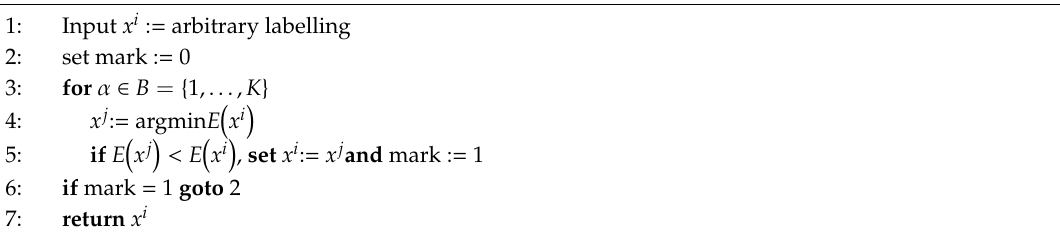
Algorithm 1 The α − expansion algorithm based on graph